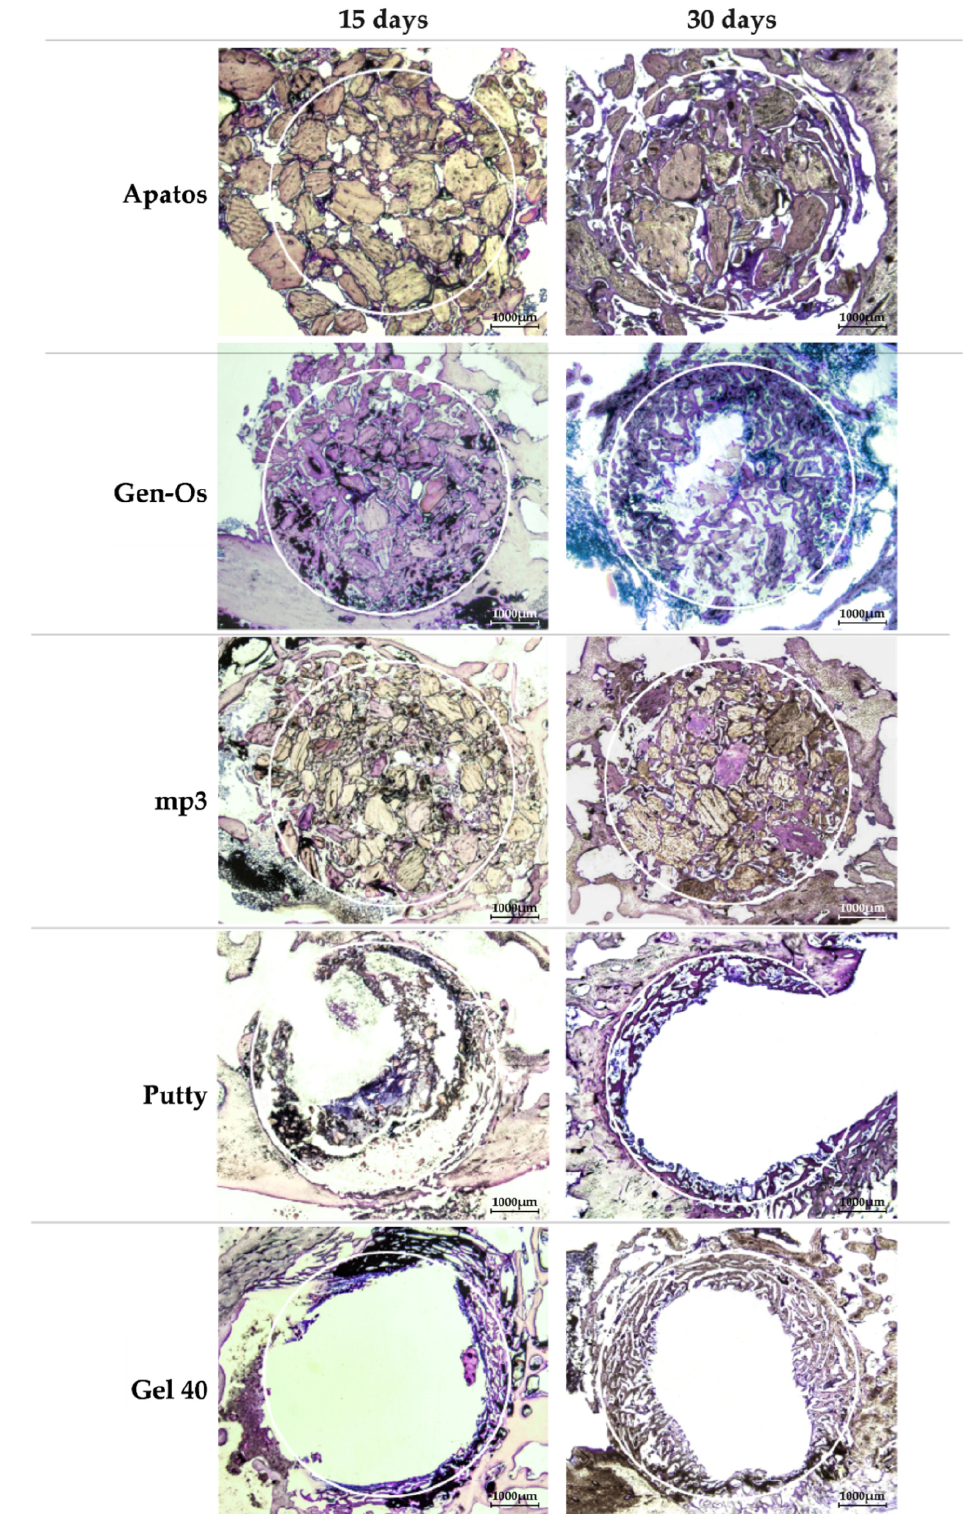
Figure 6. Cross section images of defects at 15 and 30 days of evolution, filled with the tested materials (15 × original